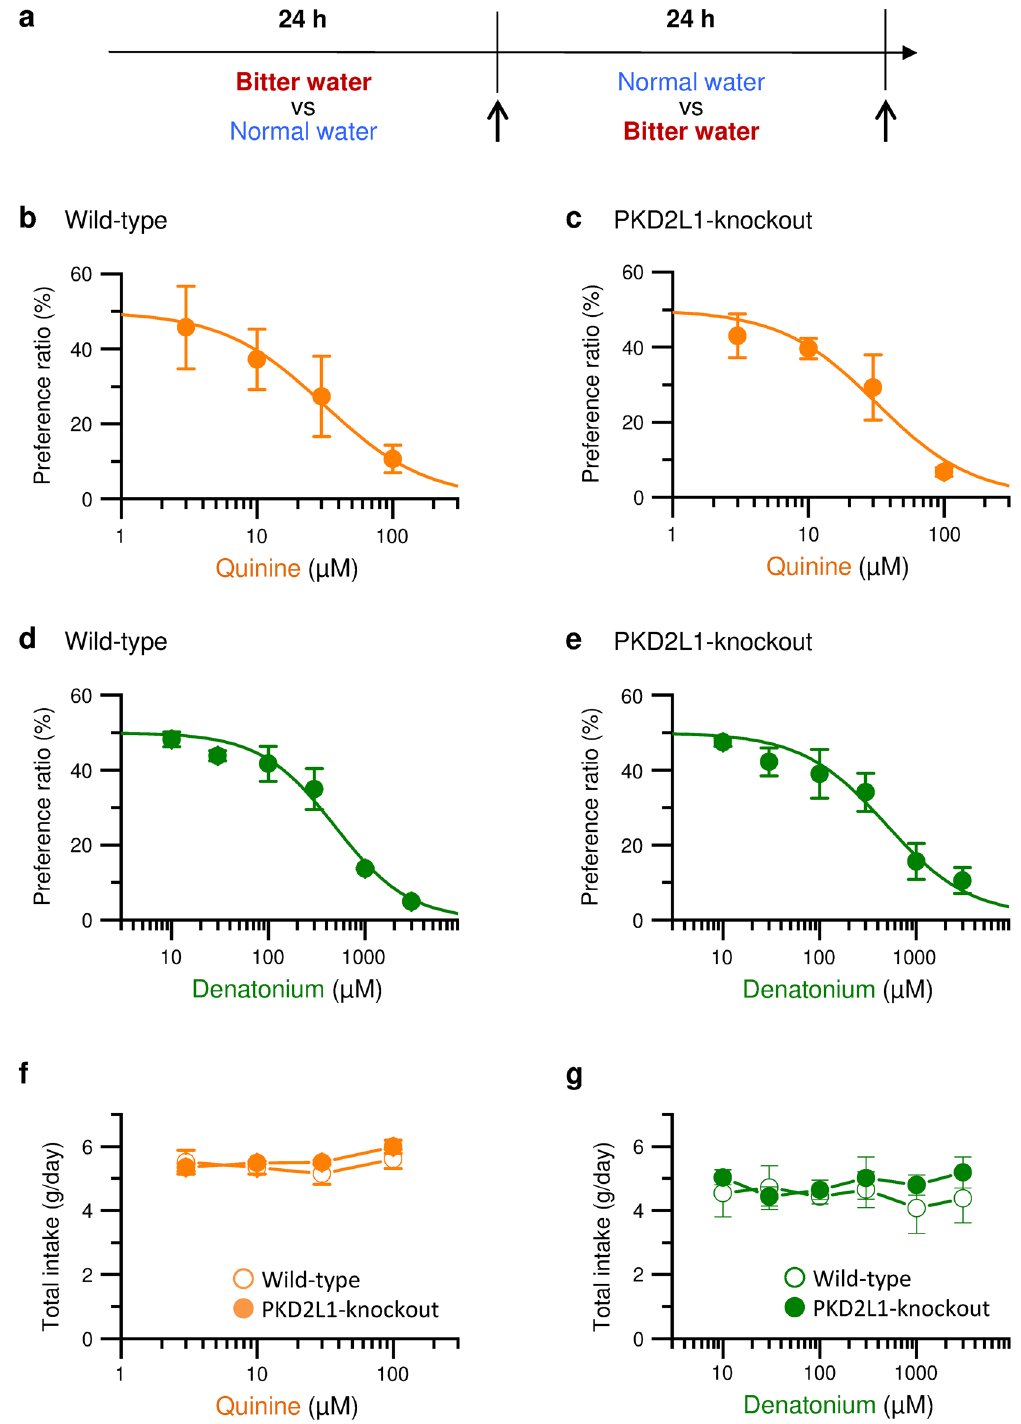
Figure 4. Intakes of quinine- or denatonium-containing water in long-term two-bottle preference tests in mice. ( a ) Timeline of experimental protocols. Arrows indicate the timing that two bottles were replaced and the intake was measured. ( b – e ) Behavioral responses to 3–100 µM quinine ( b , c ) or 10–3000 µM denatonium ( d , e ) in the wild-type ( b , d ) or the PKD2L1-knockout ( c , e ) mice. Two bottles of bitterant-containing water and normal water were given for 48 h. The preference ratio of 50% means that the intake of bitterant-containing water is the same as normal water. ( f , g ) Total amount of intakes of normal water and quinine- ( f ) or denatonium-containing water ( g ) per day by the wild-type and the PKD2L1-knockout mice. P values are determined by unpaired two- tailed Student’s t-test. The data are averaged from three